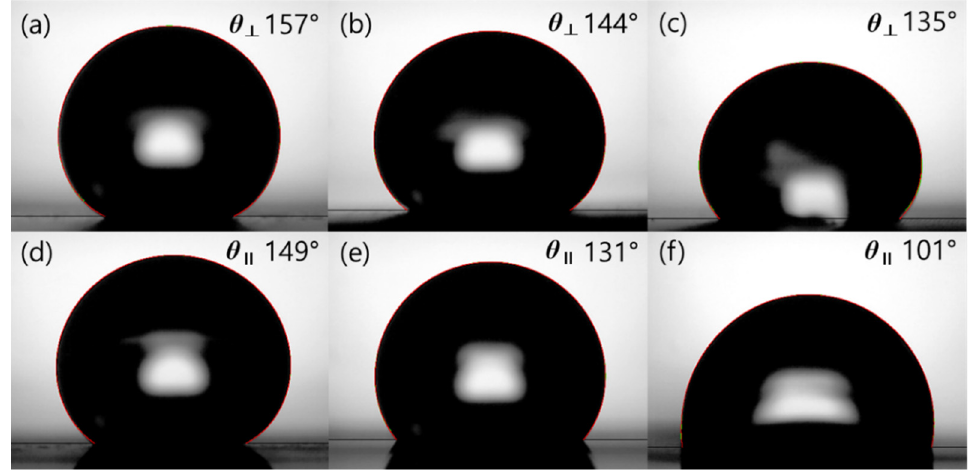
Figure 7. Water droplet contact angles on the microscale groove pattern surfaces without coating in the direction parallel to groove patterns with ( a ) 10 μ m, ( b ) 20 μ m, and ( c ) 30 μ m depths, and in the direction perpendicular to the groove patterns with ( d ) 10 μ m, ( e ) 20 μ m, and ( f ) 30 μ m depths.